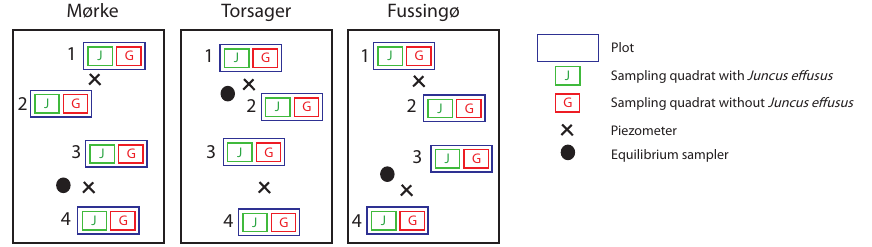
Figure 1. Experimental design. The three grassland sites each had four plots (1–4) consisting of two sampling quadrats for gas flux measure- ment with either grass alone (G) or grass with a tussock of Juncus effusus (J). Between each pair of plots, a piezometer was installed (x). Soil molar fraction profiles of methane (CH 4 ) were determined at five depths (from 5 to 100cm) using equilibrium samplers ( • ) installed next to one of the